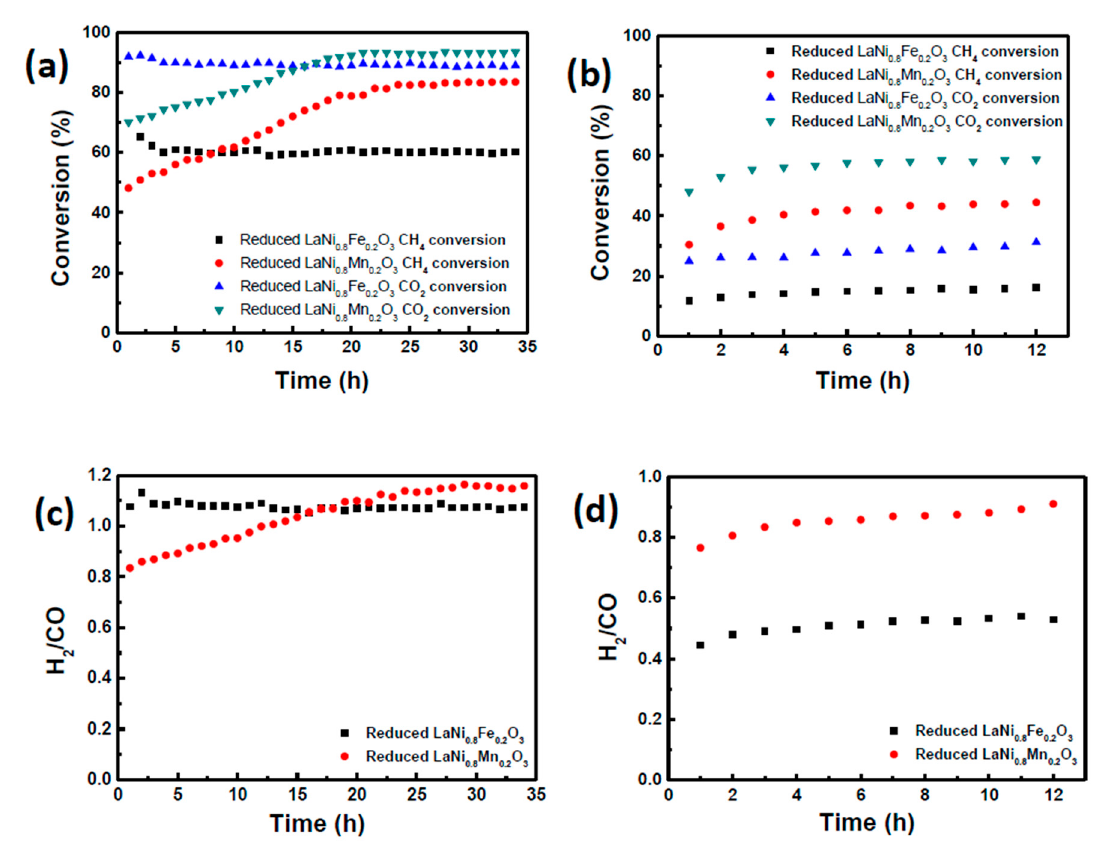
Figure 4. Conversion of methane and carbon dioxide of reduced LaNi 0.8 Fe 0.2 O 3 and LaNi 0.8 Mn 0.2 O 3 catalysts at ( a ) 800 °C and ( b ) 650 °C. H 2 :CO product ratio of reduced LaNi 0.8 Fe 0.2 O 3 and LaNi 0.8 Mn 0.2 O 3 catalysts at ( c ) 800 °C (d) at 650 °C.